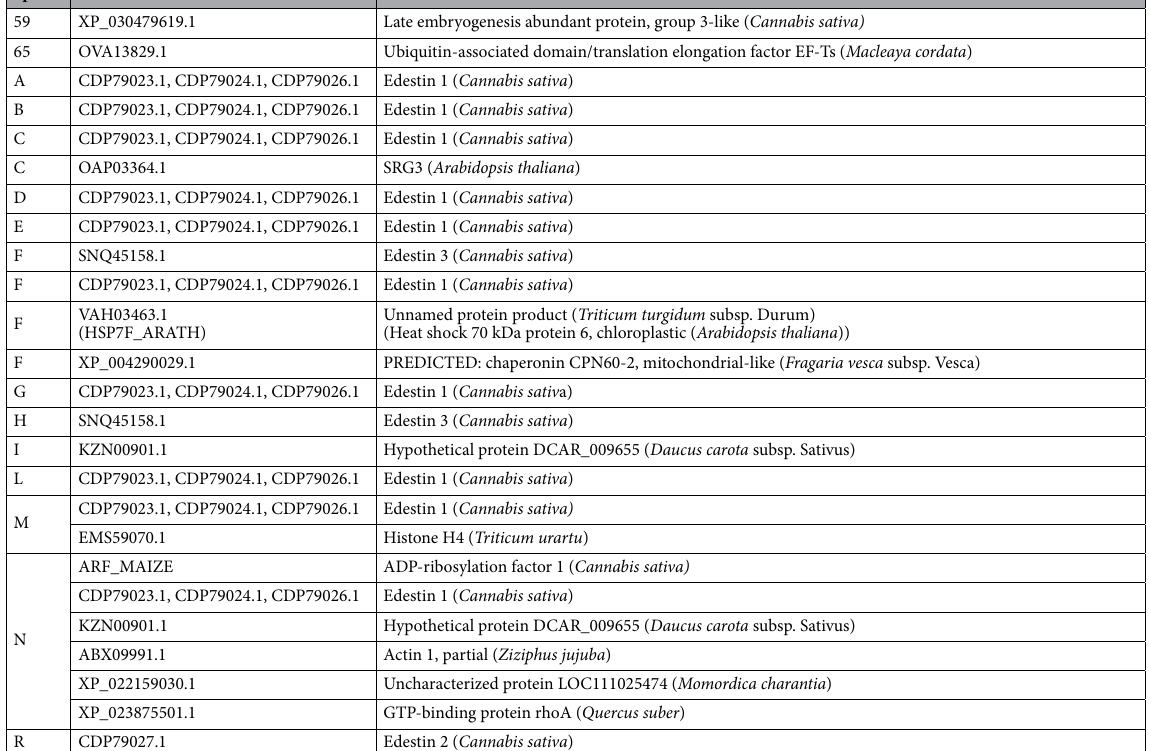
Table 3. Proteins identified after MS/MS analysis of albumin protein extracts from hemp seeds of Futura75 and Finola varieties analyzed by 2D-PAGE. Spot number, database accession number, protein name and organism are